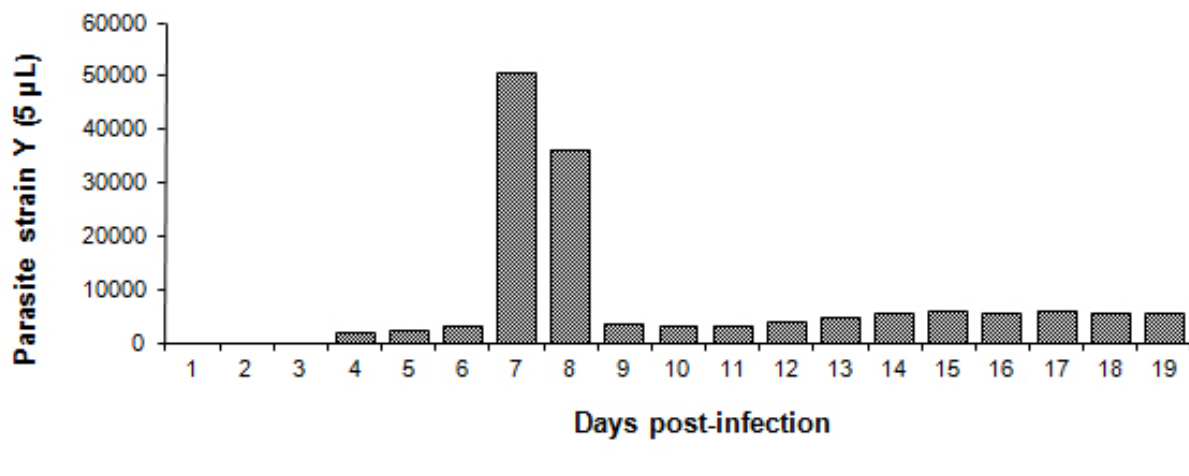
Figure 1. Parasite load in BALB/c mice after infection with 1 x 10 5 trypomastigotes/mL of T. cruzi strain Y . Data represent the mean number of parasites (ten mice per